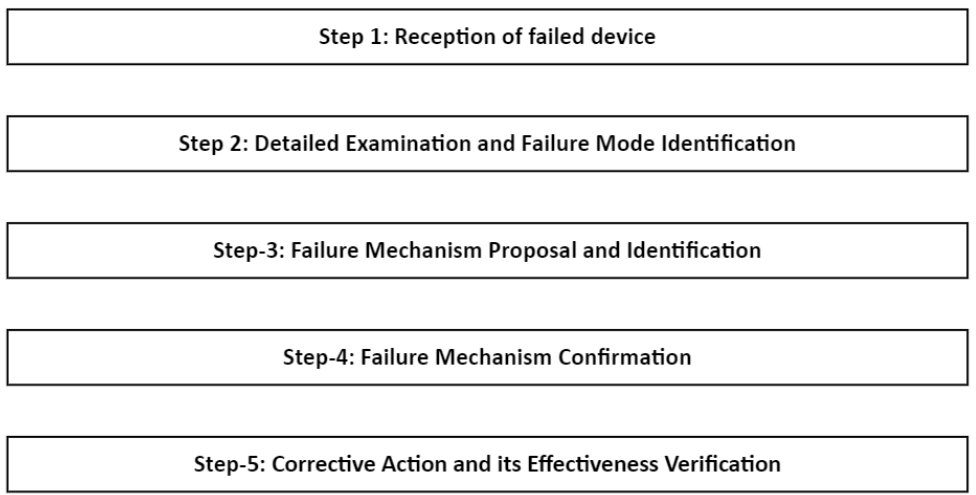
Figure 10. Flow chart of the failure analysis process.